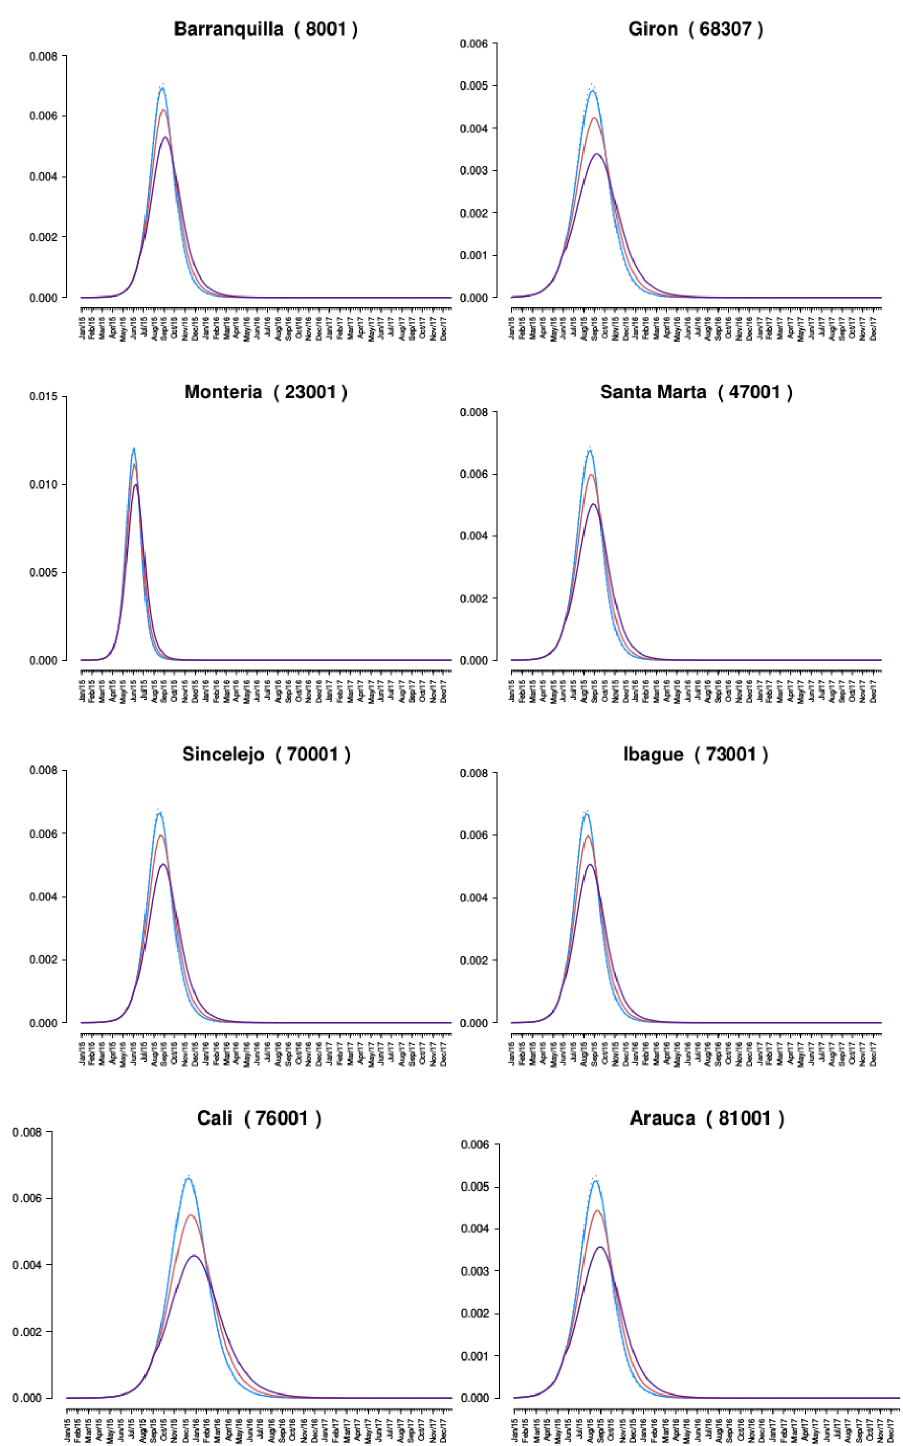
Fig 3. Comparison of the proportion of symptomatic infections of the best fit and the behavior of the epidemics when policies are implemented at th = 20%. Y-axis is a proportion (infected / at risk population), and the x-axis is time (in weeks). Best fit is dashed line, and policy 1,2, and 3 are colored blue, red, and purple, respectively.